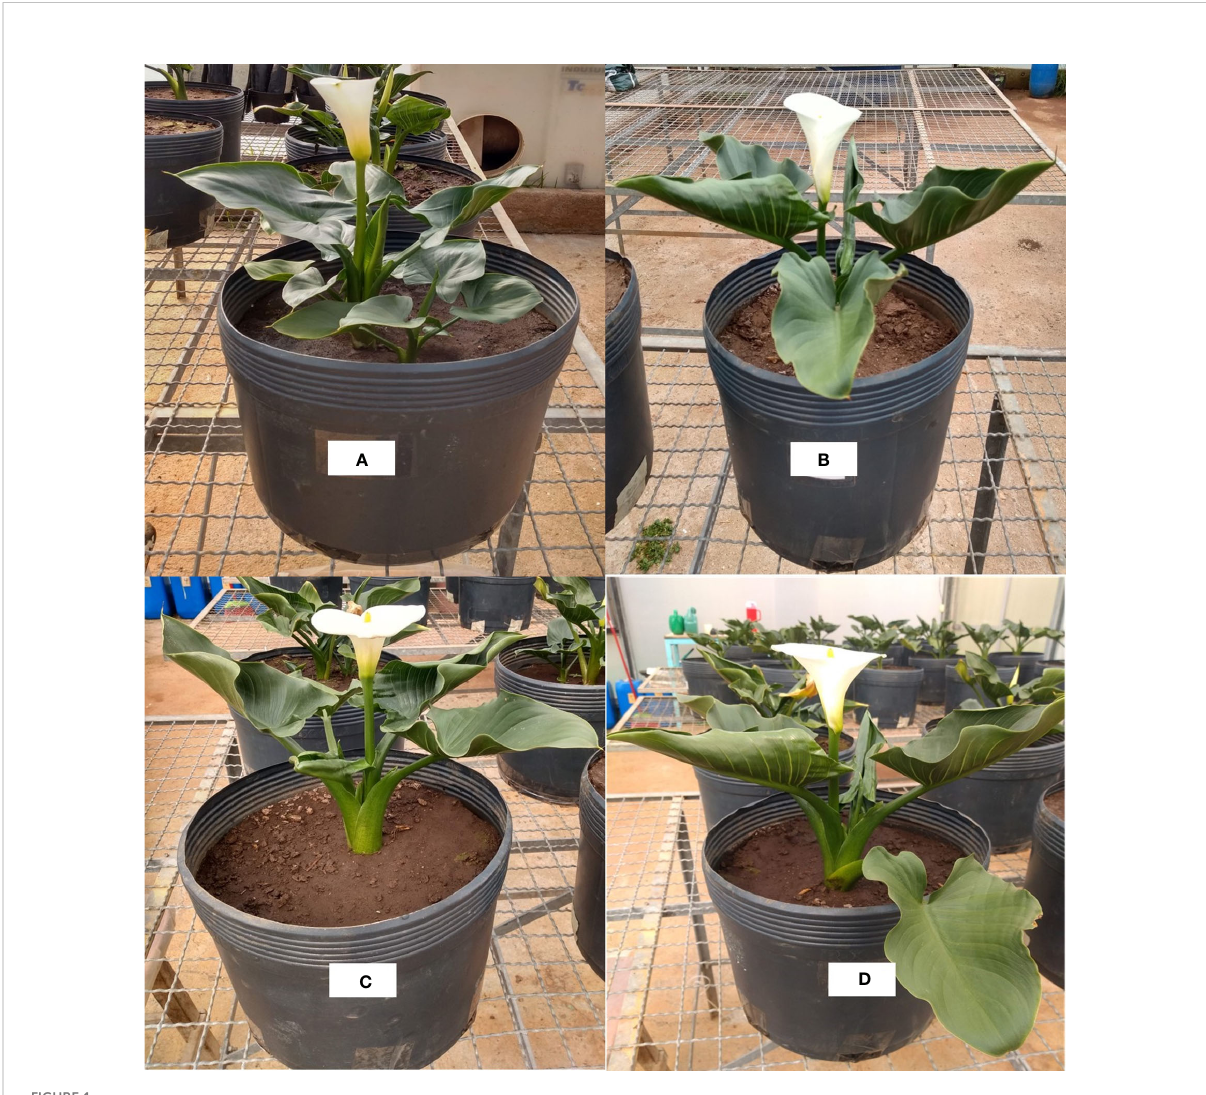
FIGURE 1 Aspect of calla lily grown in substrates with or without enro fl oxacin addition. (A) Soil + manure; (B) Contaminated soil + manure; (C) Soil + contaminated manure; (D) Contaminated soil + contaminated